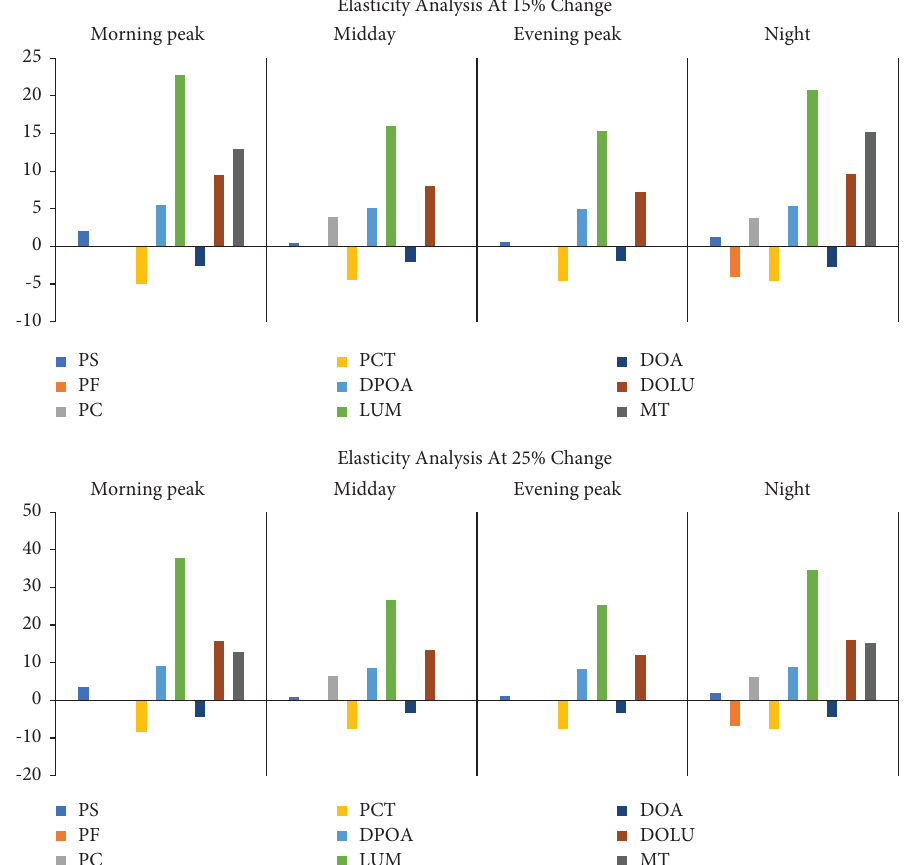
Figure 9: Elasticity analysis for weekends. Note . PS � proportion of students, PF � proportion of female, PC � proportion of commuters, PCT � proportion of commuters using who public transit, DPOA � density of park and open space area, LUM � land use mix, DOA � density of ofce area, DOLU � density of other land use area, MT � medium